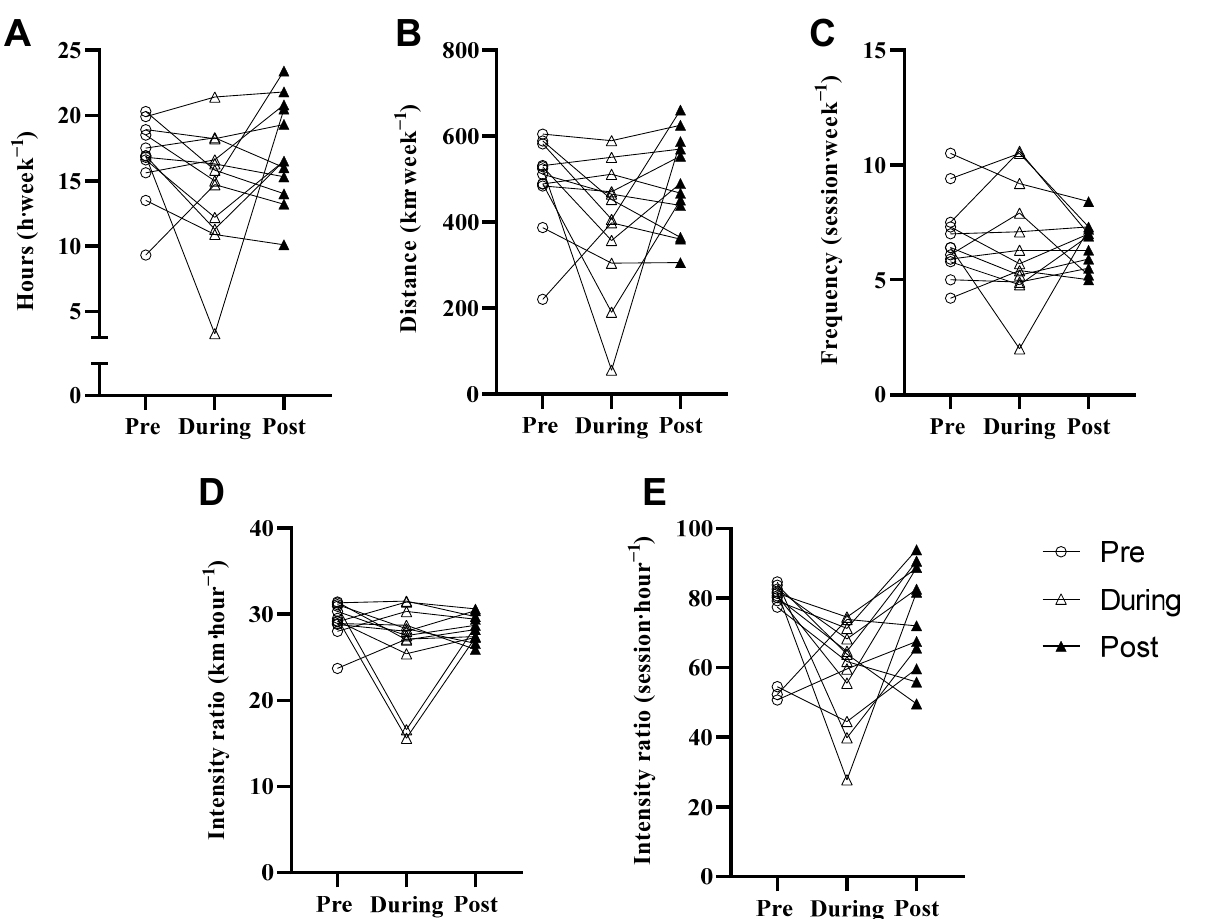
Figure 1. Non-significant differences in training hours ( A ), distance ( B ), frequency ( C ) and intensity ratios ( D , E ) between 30 days pre, during, and post COVID-19 restrictions. Physiological Performance Measures.